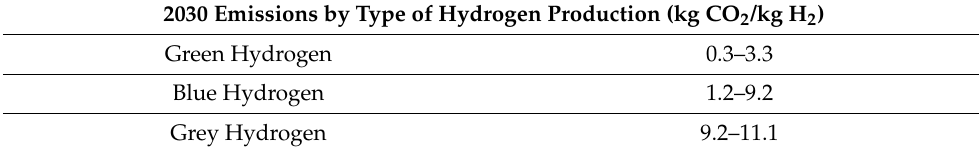
Table 3. Emission from different methods of hydrogen